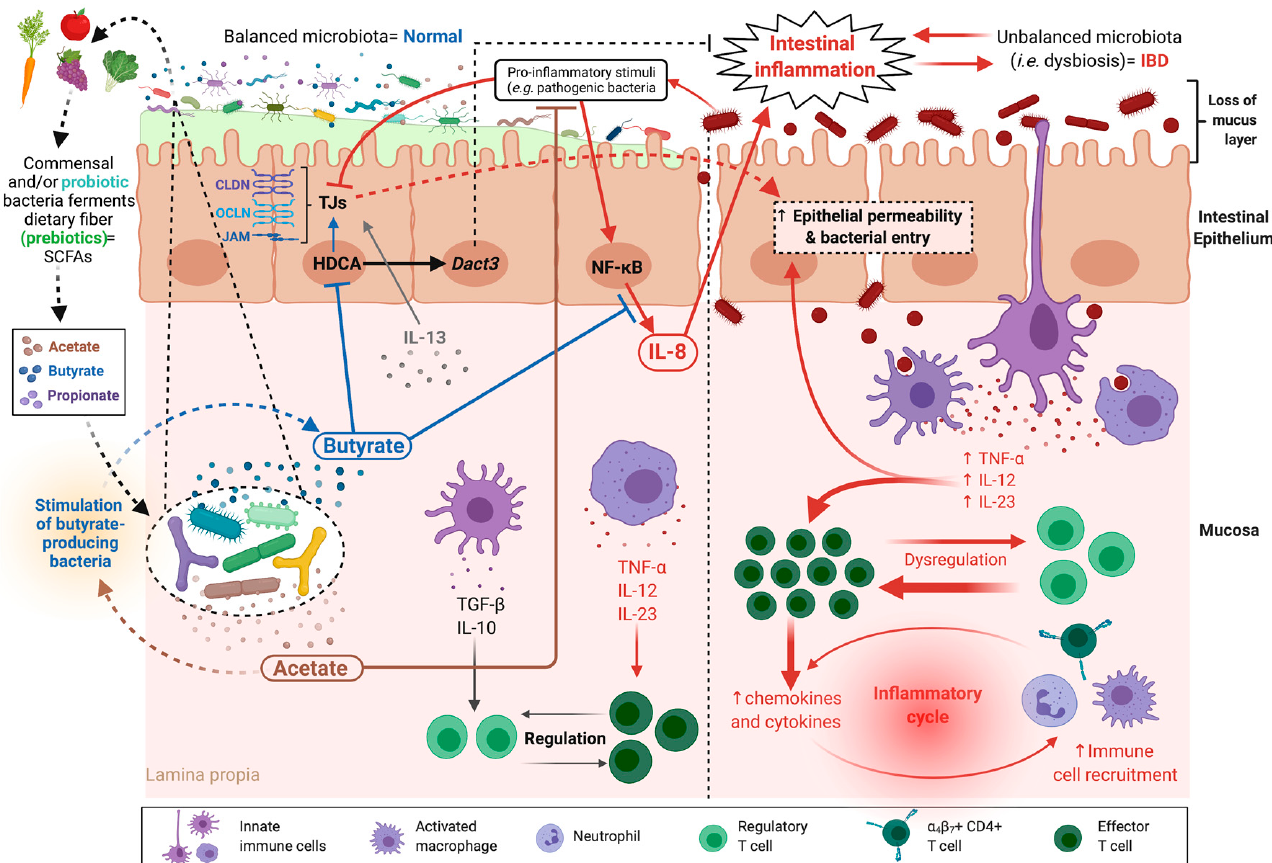
Figure 2. Increased intestinal permeability in inflammatory bowel diseases (IBD). In IBD-related disorders, the intestinal permeability is increased, the thickness of the mucus layer is decreased, and normal microbiota is unbalanced, resulting in bacteria entry to mucosa and activation of the mucosal immune system. Significant dysregulation of cytokine and chemokine levels is observed, which induces an inflammatory cycle. Pro-inflammatory stimuli induced by pathogenic bacteria, together with IL-13 produced by the inflammatory cells of the mucosa, dysregulate tight junction (TJ) protein expression, which enhances intestinal hyperpermeability, and activate enterocytes to secrete IL-8 and other inflammatory mediators. Probiotic bacteria, their by-products, such as the short-chain fatty acids (SCFAs) butyrate and acetate, and prebiotics modulate dysbiosis and restore a balanced microbiota. They also skew the immune microenvironment to an anti-inflammatory profile. The main target molecules of these therapies in the treatment of IBD are indicated. (This figure was created with Biorender.com, access date: 24 May